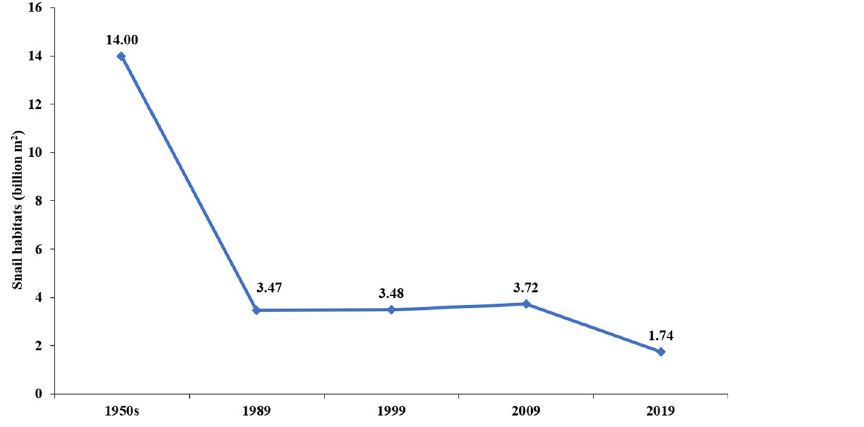
Fig 4. Changes in the area of O . hupensis snail habitats in China from 1950s to